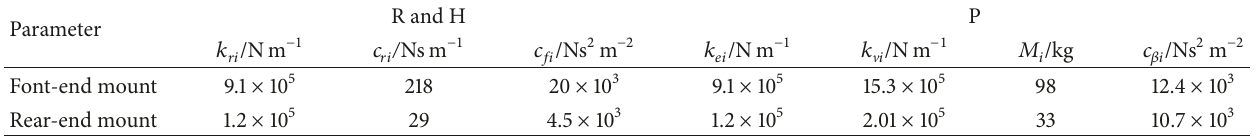
Table 3: The lumped parameters of rubber (R), hydraulic (H), and pneumatic (P) mounts.